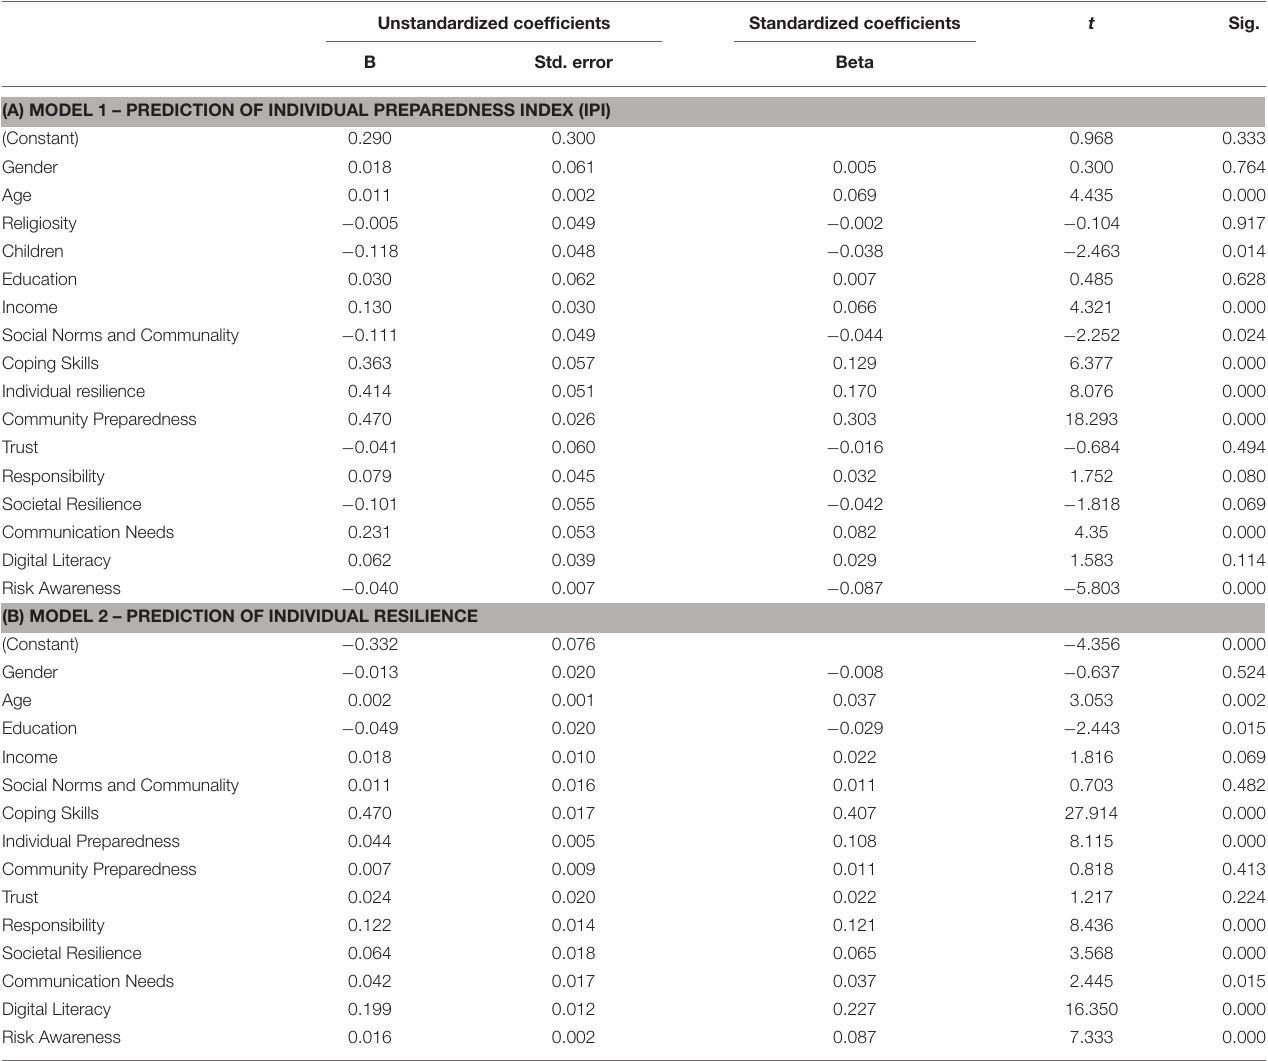
TABLE 5 | Result of linear regression analysis to predict individual resilience ( N =